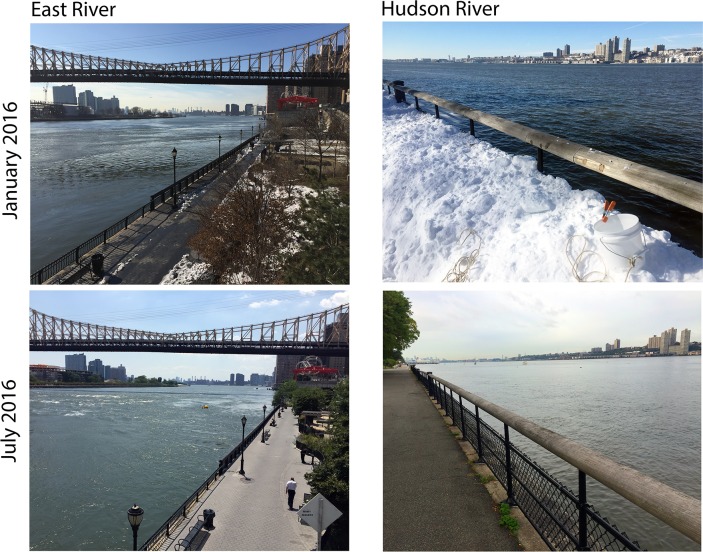
Collection sites, views south towards New York harbor.Collection equipment (bucket, rope) visible in upper right panel.